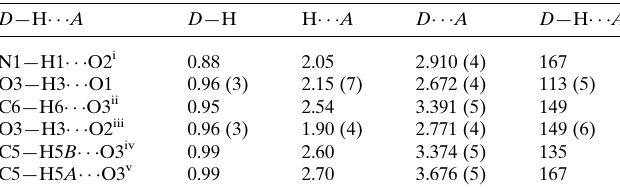
Table 1 Hydrogen-bond geometry (A˚ , (cid:4) ).